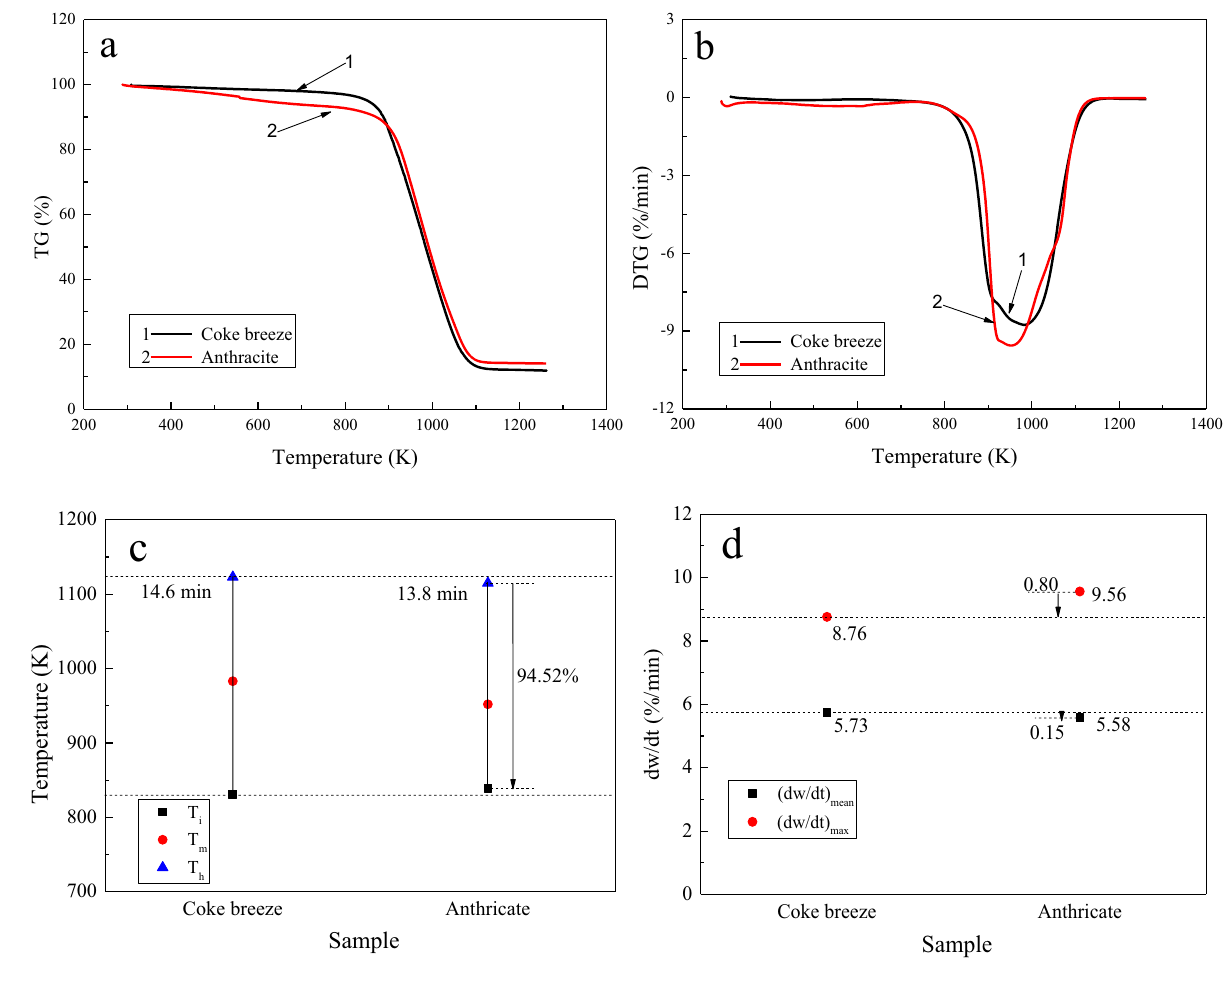
Figure 4. Combustion behaviors of coke breeze and anthracite ( a ) TG profile, ( b ) DTG profile, ( c ) combustion temperatures and burnout times, and ( d ) maximum weight loss rate and mean weight loss rate.